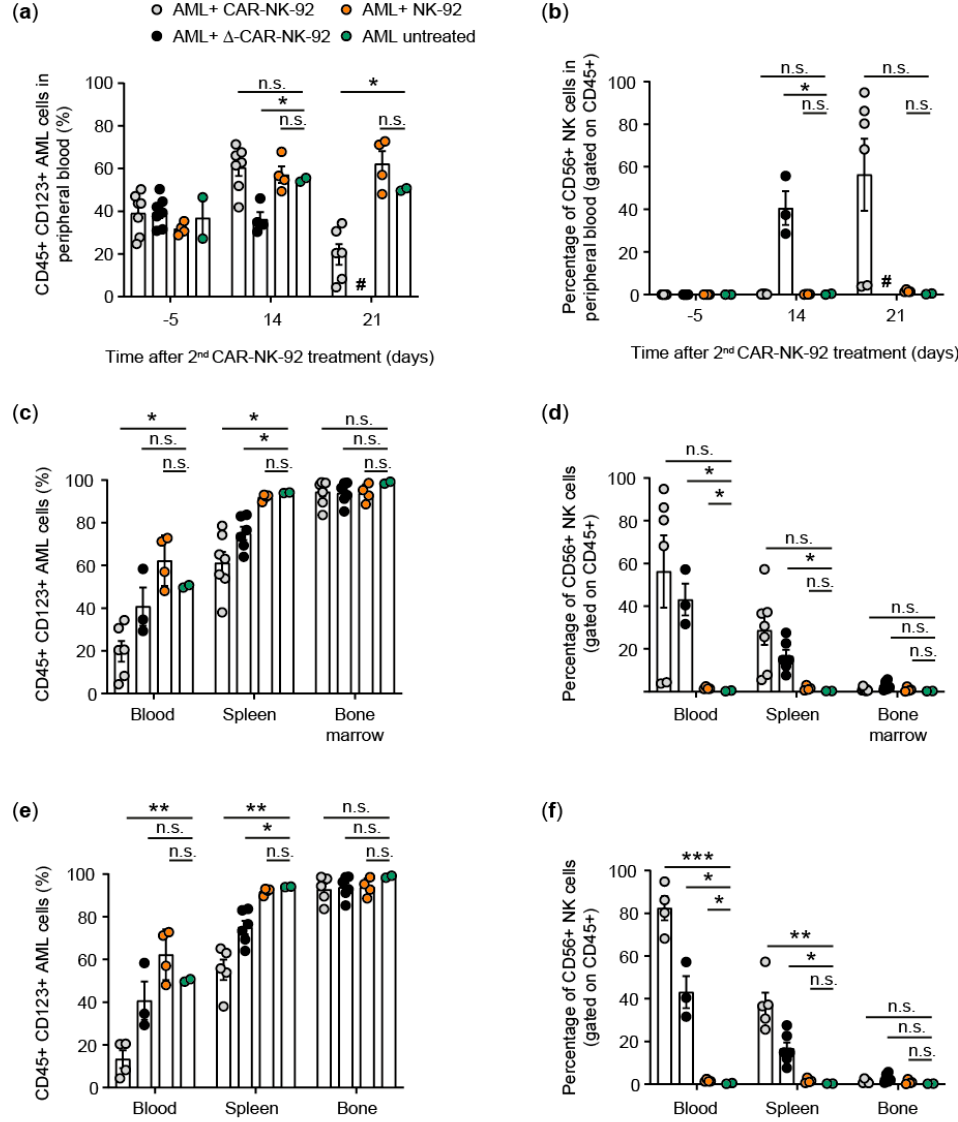
Figure 4. Anti-leukemic activity of CAR-NK-92 cells in vivo. ( a ) Reduction of AML blasts in peripheral blood following infusion of 5 × 10 6 ∆ -CAR-NK-92 or full-length CAR-NK-92 cells. # All ∆ -CAR-NK-92 died or were sacrificed due to illness one week earlier. ( b ) Persistence of hIL-15-expressing ∆ -CAR-NK-92 and CAR-NK-92 cells as measured by the hCD45 + CD56 + population. ( c ) AML burden at time of sacrifice. AML blast percentages were determined in the peripheral blood, spleen, and bone marrow via flow cytometric analyses for hCD45 + CD123 + cells. ( d ) NK cell persistence at time of sacrifice. NK-92 levels were determined in the peripheral blood, spleen and bone marrow via flow cytometric analyses for hCD45 + CD56 + cells. ( e ) and ( f ) show the AML level and NK-92 cell persistence at the time of sacrifice as in panels c and d , respectively, but the two mice in the CAR-NK-92 group that showed no NK-92 persistence were excluded. Data are shown as mean ± standard error of mean (SEM) and the unpaired t -test was used to assess differences between groups. Statistically significant differences are indicated by * ( p ≤ 0.05), ** ( p ≤ 0.01), *** ( p ≤